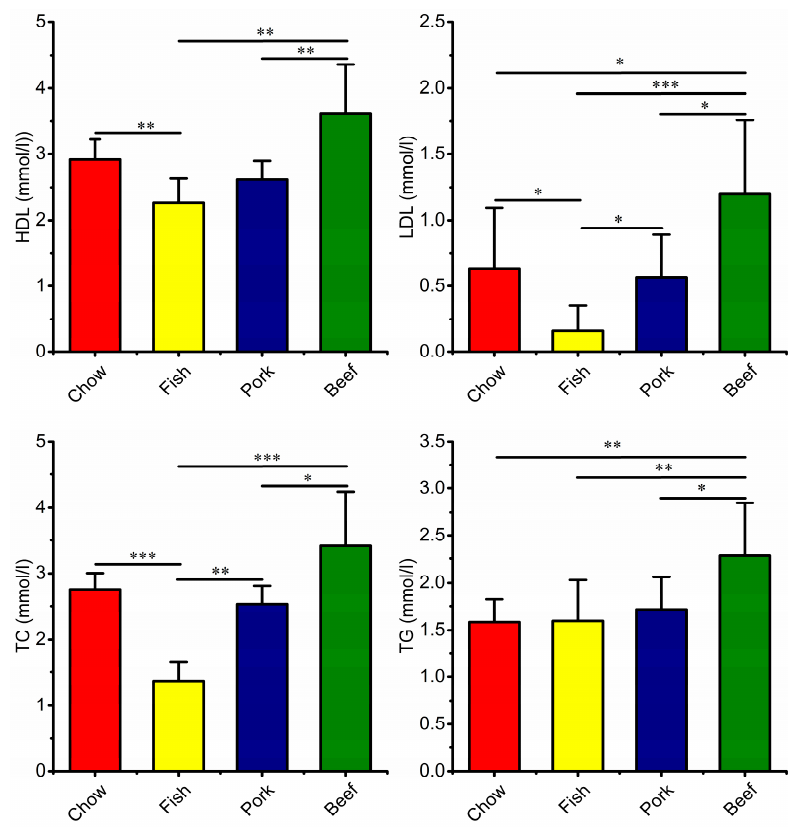
Figure 5. Differences in blood metabolites of mice fed laboratory chow, fish, pork, or beef. HDL, high-density lipoprotein; LDL, low-density lipoprotein; TC, total cholesterol; TG, triglycerides. Data are mean ± SD, the numbers of mice in each group were: chow 10; fish, 10, pork, 10; beef, 9. * p < 0.05, ** p < 0.01, *** p < 0.001.